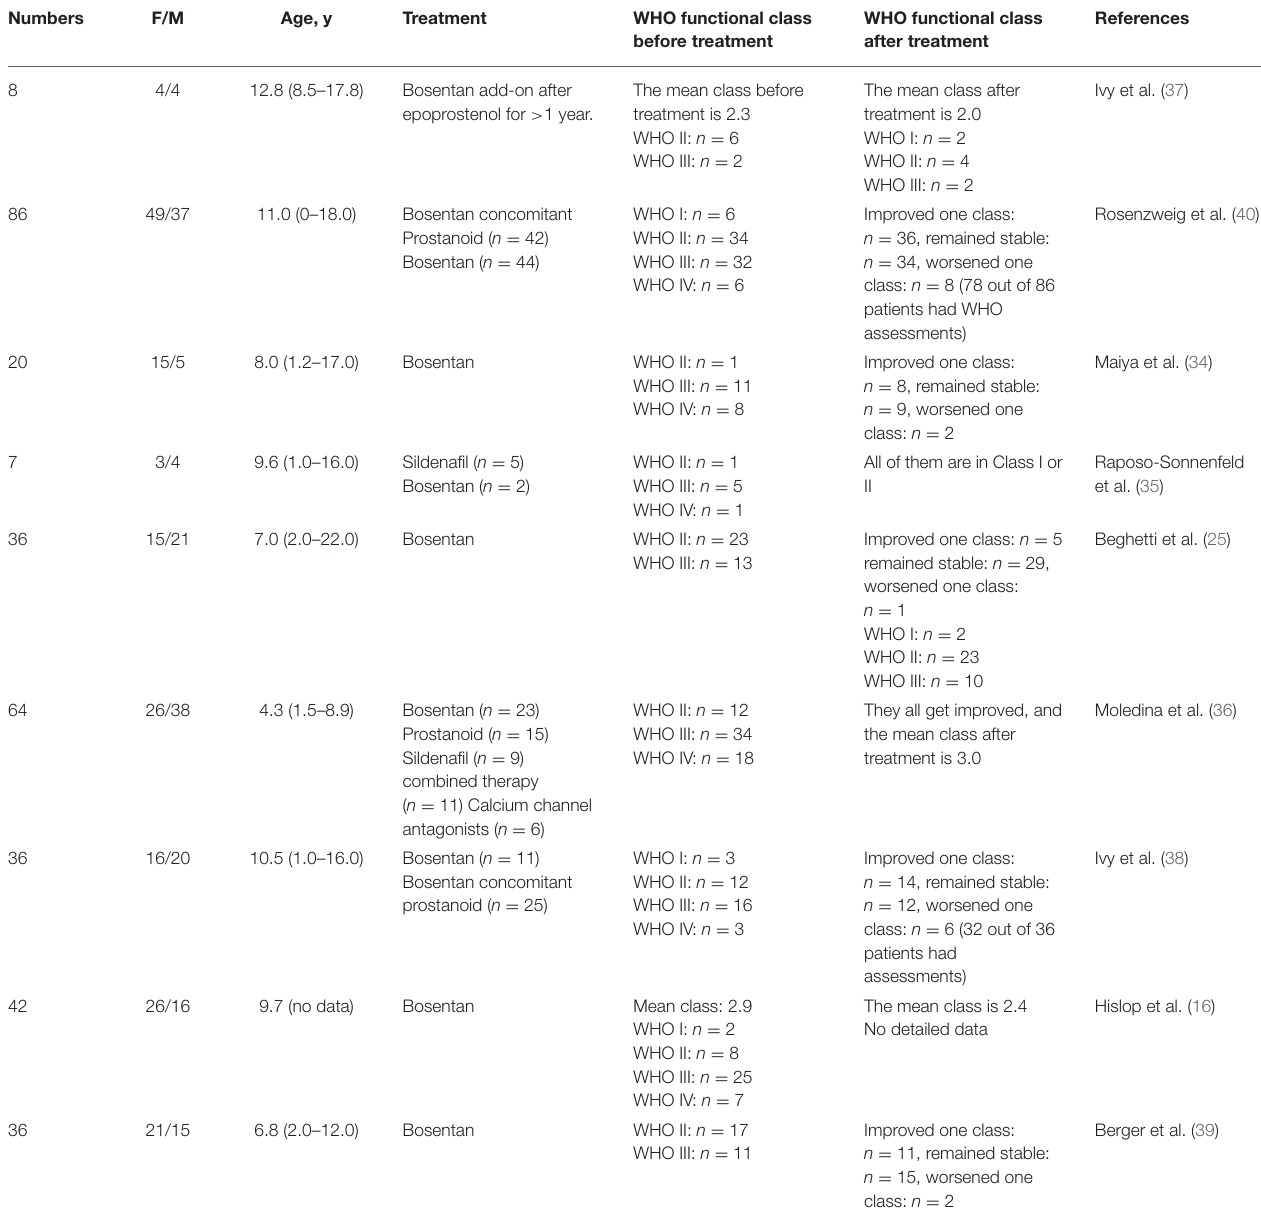
TABLE 2 | WHO functional class of pediatric IPAH patients treated by